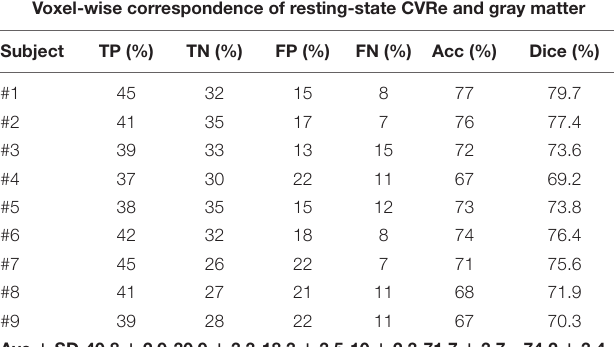
computations were restricted only to voxels within gray